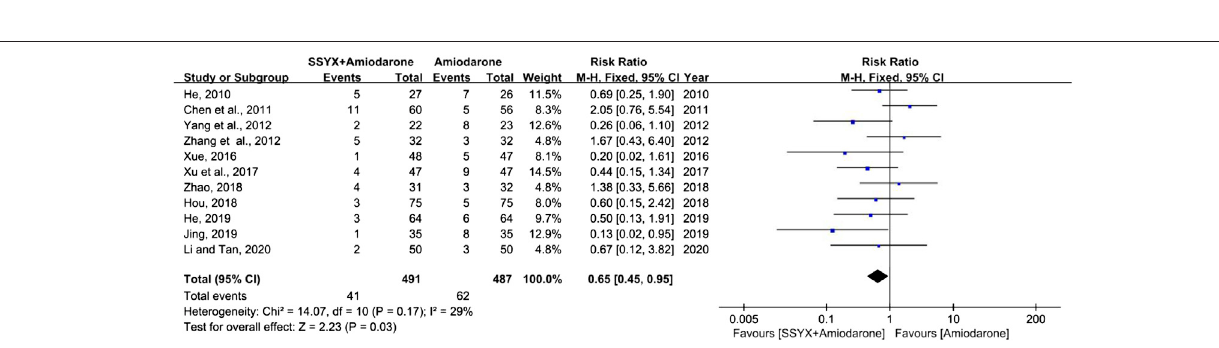
Frontiers in Pharmacology |